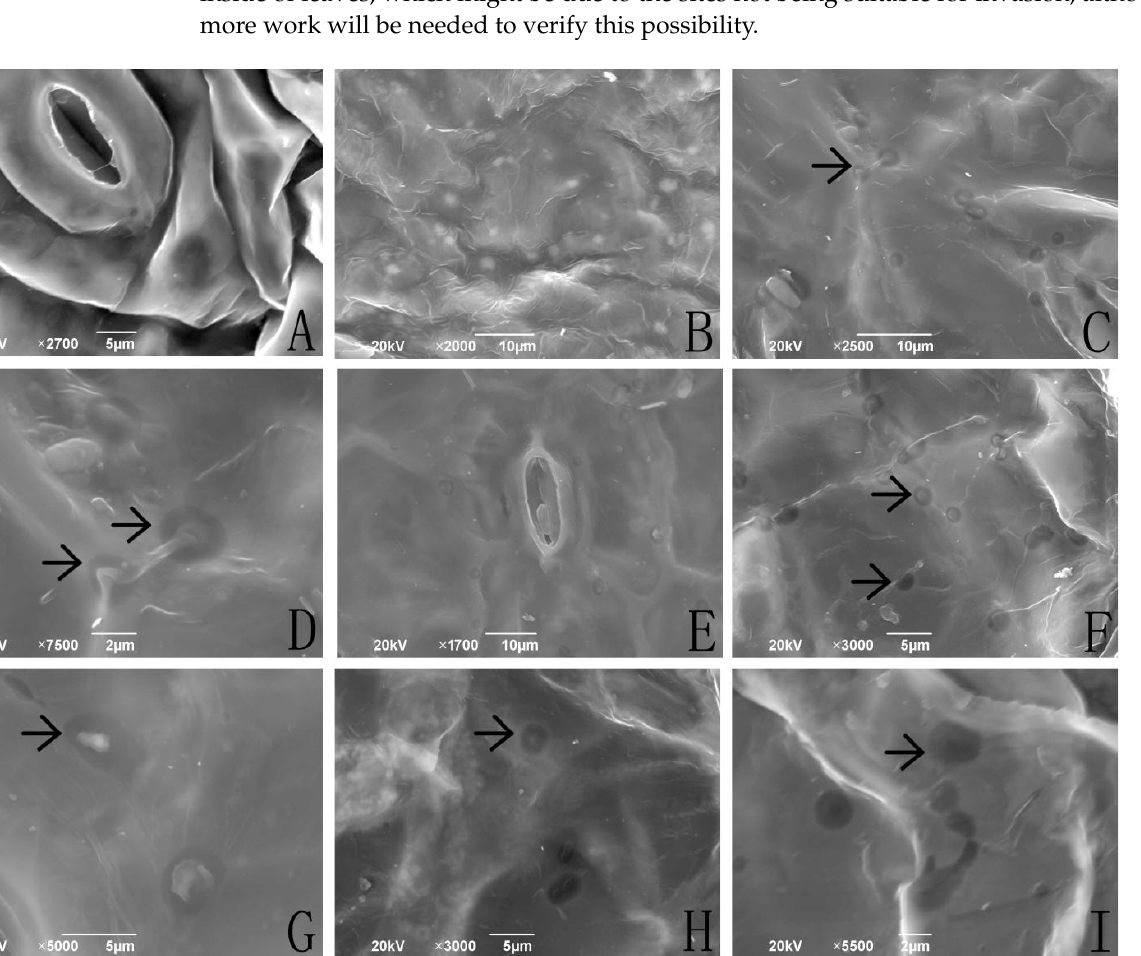
Figure 1. I. cateinannulata submerged conidia colonization of buckwheat leaf as assessed via scan- ning electron microscopy. Note: ( A ) Control group, no attachment or submerged conidial coloniza- tion were observed during the study period. ( B ) Submerged conidia (diameter ≤ 2 µm) were at- tached to leaf surfaces after spraying. ( C ) Submerged conidia on leaf surfaces, at 0.5 h after inocula- tion, began to invade leaf tissues, with clear evidence of tissue dissolution surrounding spores, which were primarily at leaf veins and stomata. ( D ) A germ tube was oriented in place and had transferred its nucleus into the leaf. ( E , F ) At 1–2 h after inoculation, the dissolution area of leaf tissue surrounding submerged conidia increased significantly, and these conidia gradually deformed and shrunk. ( G – J ) At 2–4 h after inoculation, the dissolution area of tissue surrounding inoculated spores gradually decreased, and numbers of submerged conidia had fallen substantially. The majority of conidia had either entered into leaves or dissolved with pit-shaped dissolution circles at this time point. Leaf morphology was normal at 4–8 h after spraying, with no morphological differences be- tween inoculated leaves and control leaves. ( K , L ) Leaf tissues after inoculation. Some conidia (di- ameter > 2 µm) did not enter the leaves and formed no visible dissolution circles, instead growing